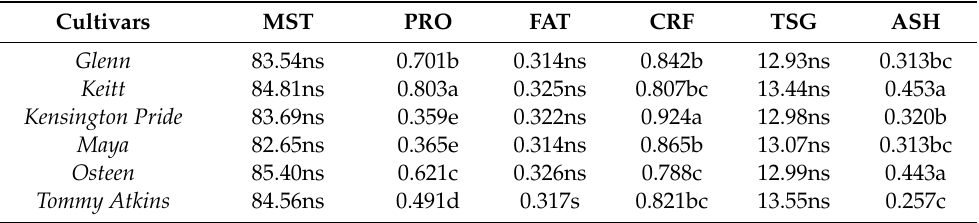
Table 5. Mango chemistry composition (g 100 g − 1 ) of the six mango cultivars in trial. Moisture (MST); proteins (PRO); fats (FAT), crude fibre (CRF); total sugars (TSG); ash (ASH). Cultivars MST PRO TSG ASH